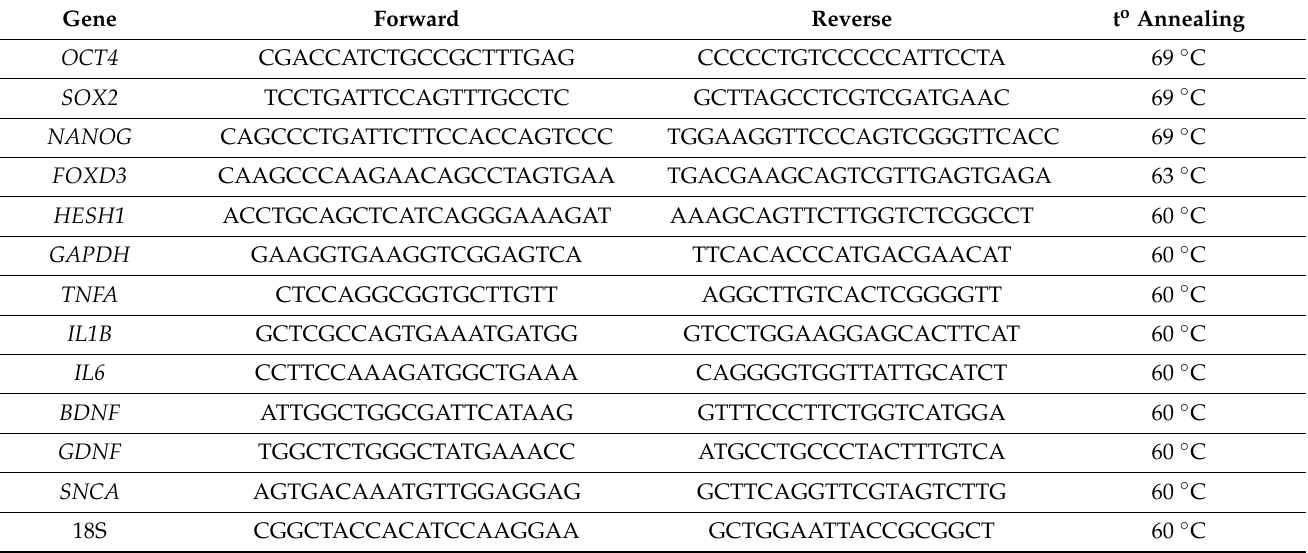
Table 3. The sequences of primers used in the